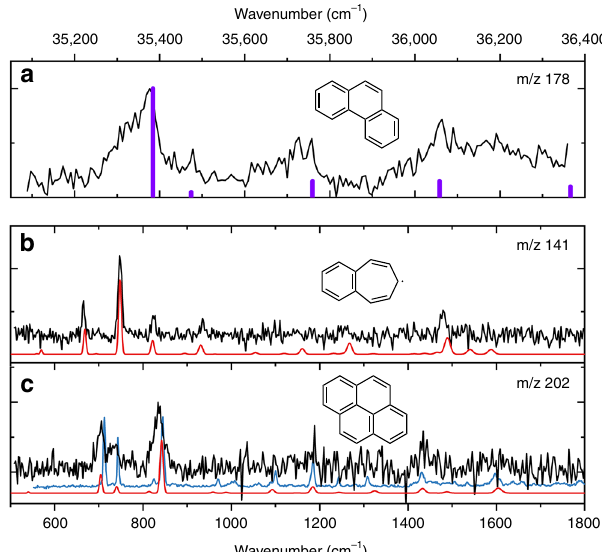
Fig. 3 Assignment of larger PAHs formed in the discharge using REMPI and IR ion dip spectroscopy. a Experimental REMPI spectrum of the m / z = 178 channel (black) with literature values of the spectrum of phenanthrene [28] (mass 178 amu) as reference (violet). b , c Experimental IR-UV ion dip spectra recorded using 36616 cm − 1 UV photon energy (black). Theoretical spectra of the assigned molecular structures displayed in red: benzo[7] annulene radical for m / z = 141 and pyrene for m / z = 202. The IR-UV ion dip spectrum of reference compound pyrene is in blue and was recorded using the methods described in ref. 69